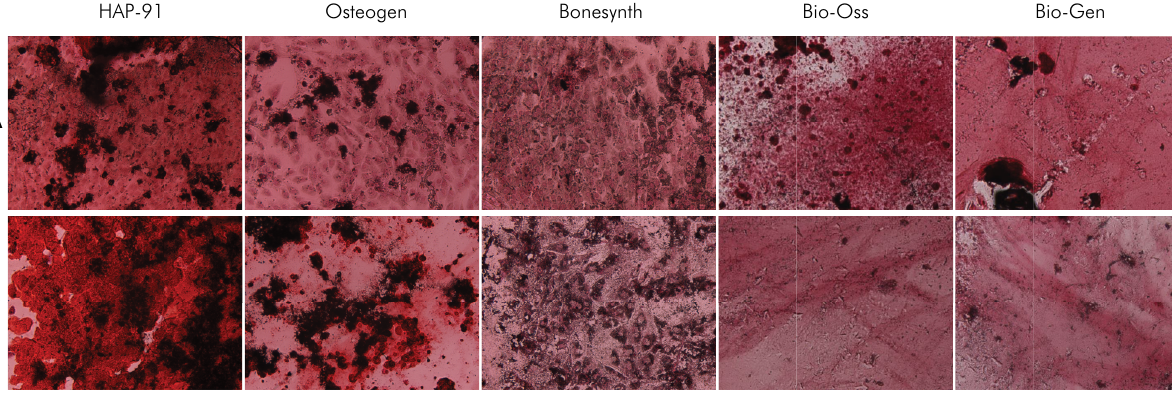
6 Braz. Oral Res.